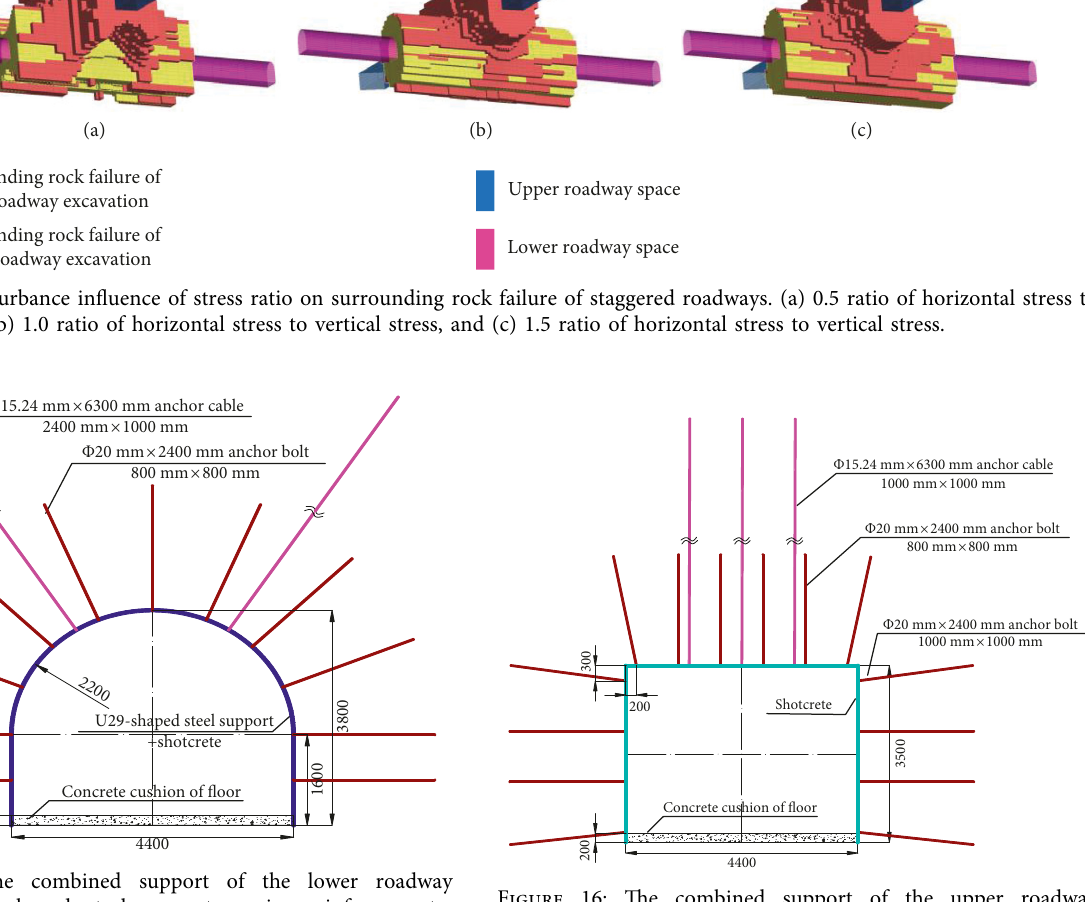
Figure 16: The combined support of the upper roadway “bolt +cable+shotcrete+concrete cushion of